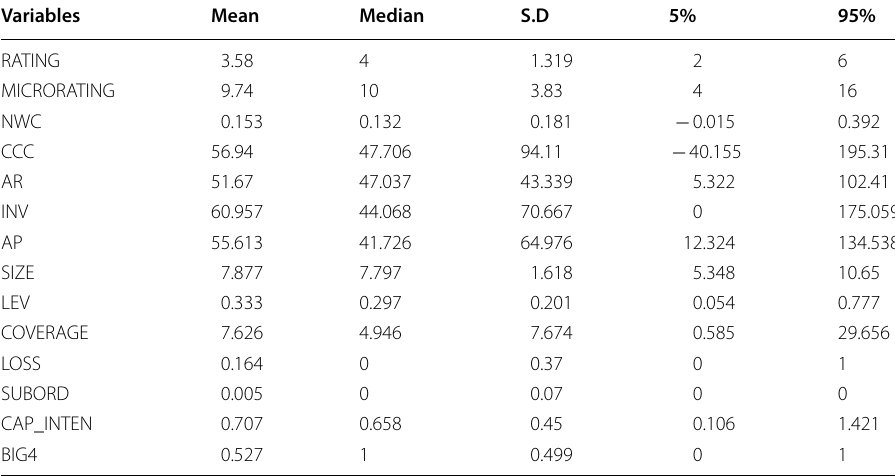
Table 3 Descriptive statistics of explanatory and control